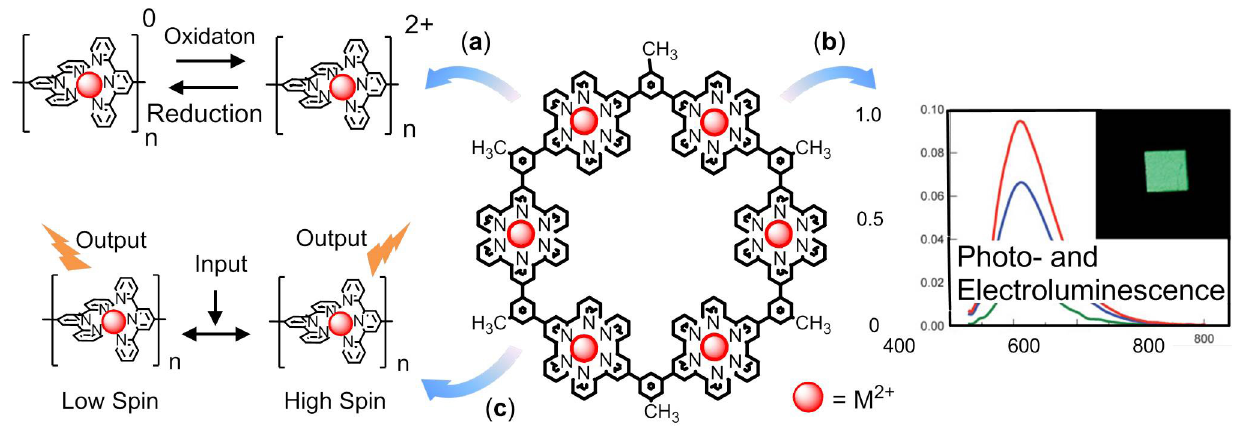
FIGURE 6 - Potential areas of utility for metallofractal materials include (a) energy storage and release, (b) optical devices, and (c) molecular switches.